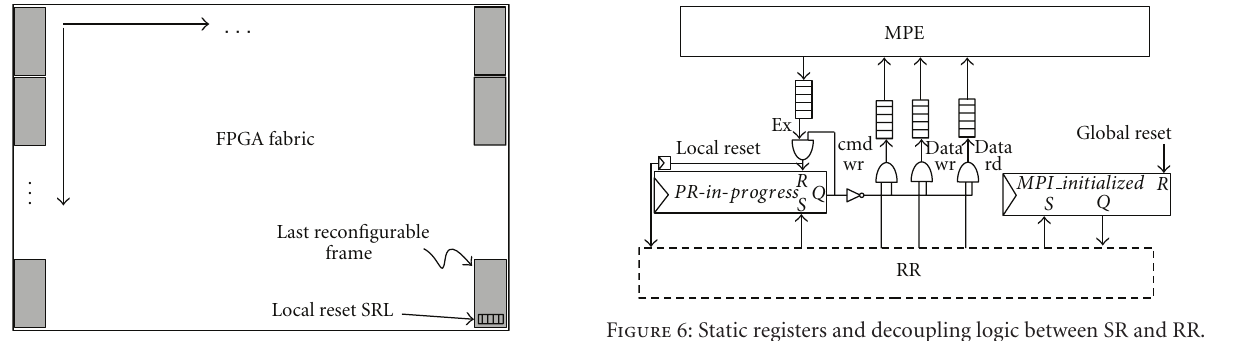
Figure 5: Placement of the reset SRL within the RR.